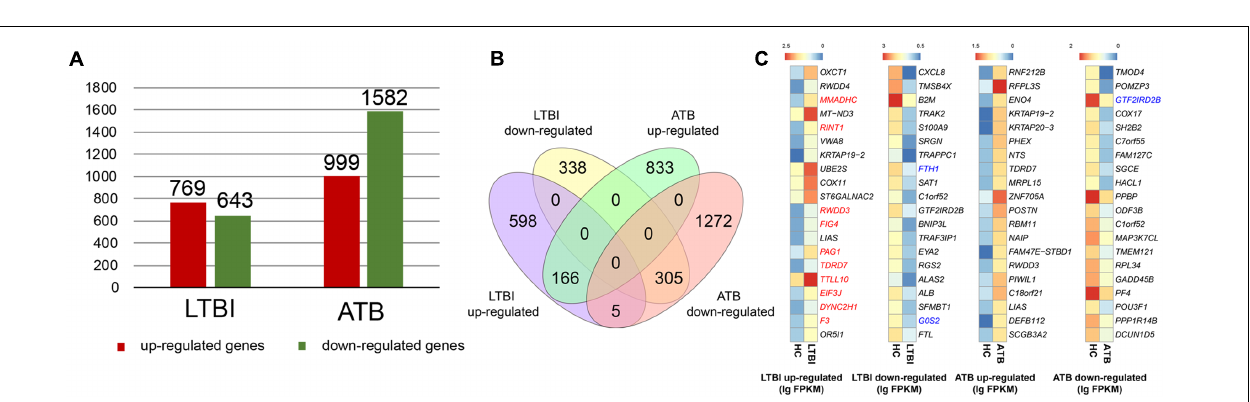
FIGURE 2 | Profiles of DEGs among HC, LTBI, and ATB samples. (A) Heatmap of DEGs among the three samples. (B) The Gene Ontology (GO) biological process categories of the top 30 percentage of the DEGs in each samples.